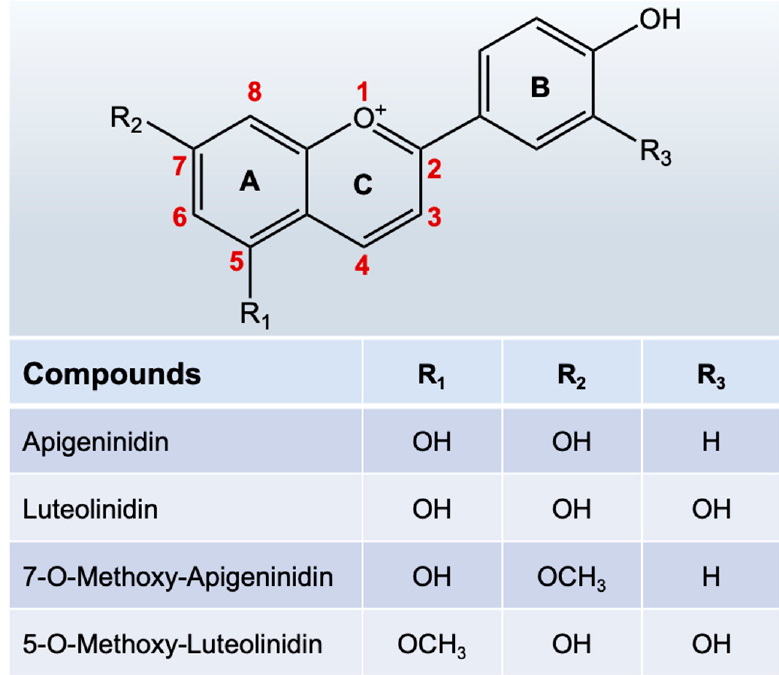
Figure 1. Structures of 3-DAs and their main derivatives in sorghum.